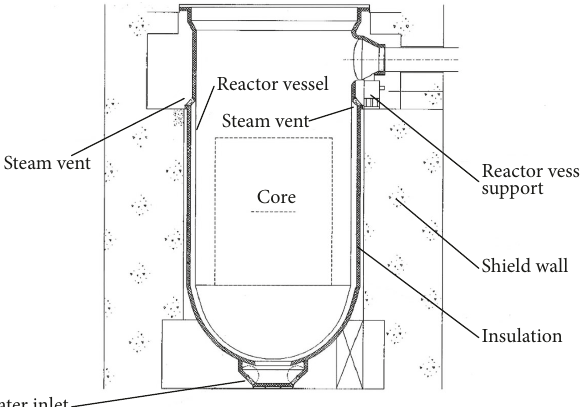
Figure 1: AP1000 RPV support layout [1].